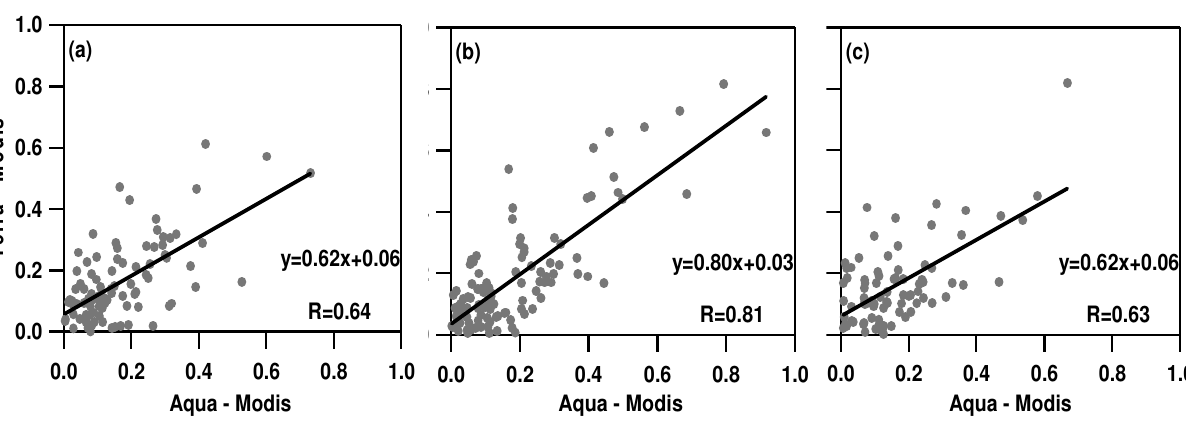
Figure 4. Scatterplot of daily-AOTs retrieved from MODIS-Terra measurements versus daily-AOTs from MODIS-Aqua measurements for a 20 × 20 km 2 box centered at Arnesano in (a) 2006, (b) 2007, and (c) 2008. The slope and intercept of regression line and linear correlation coefficient ( R ) are also given in each